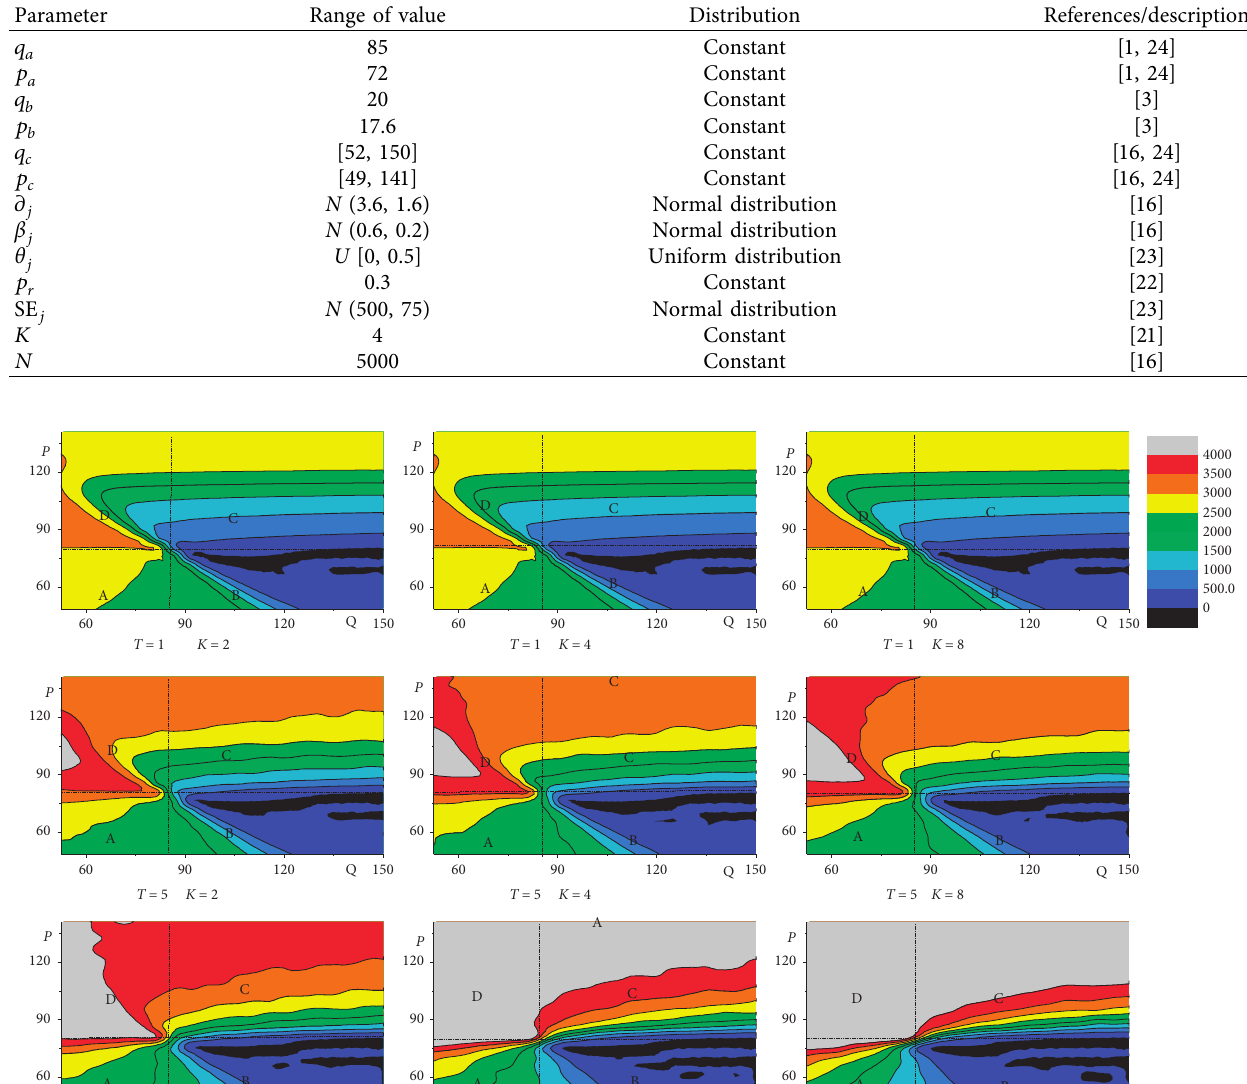
Table 2: Initial values of the basic parameters of the model.